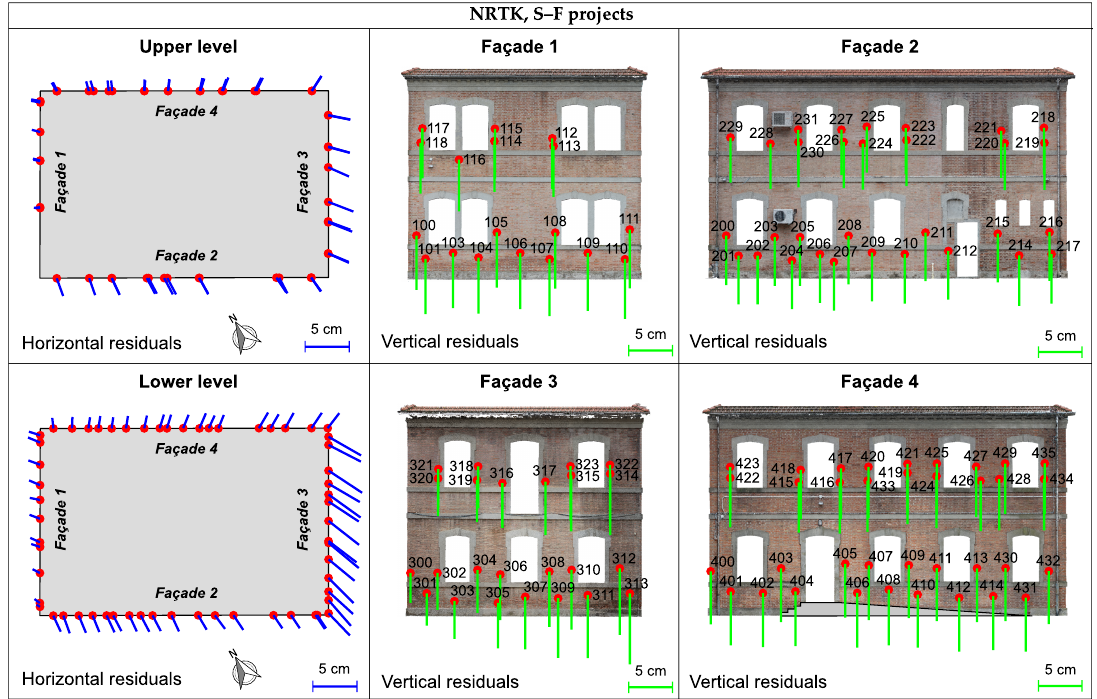
Figure 8. Horizontal and vertical residuals for NRTK image dataset processed for single façades (S–F). The results of all other processing strategies are reported in Appendix